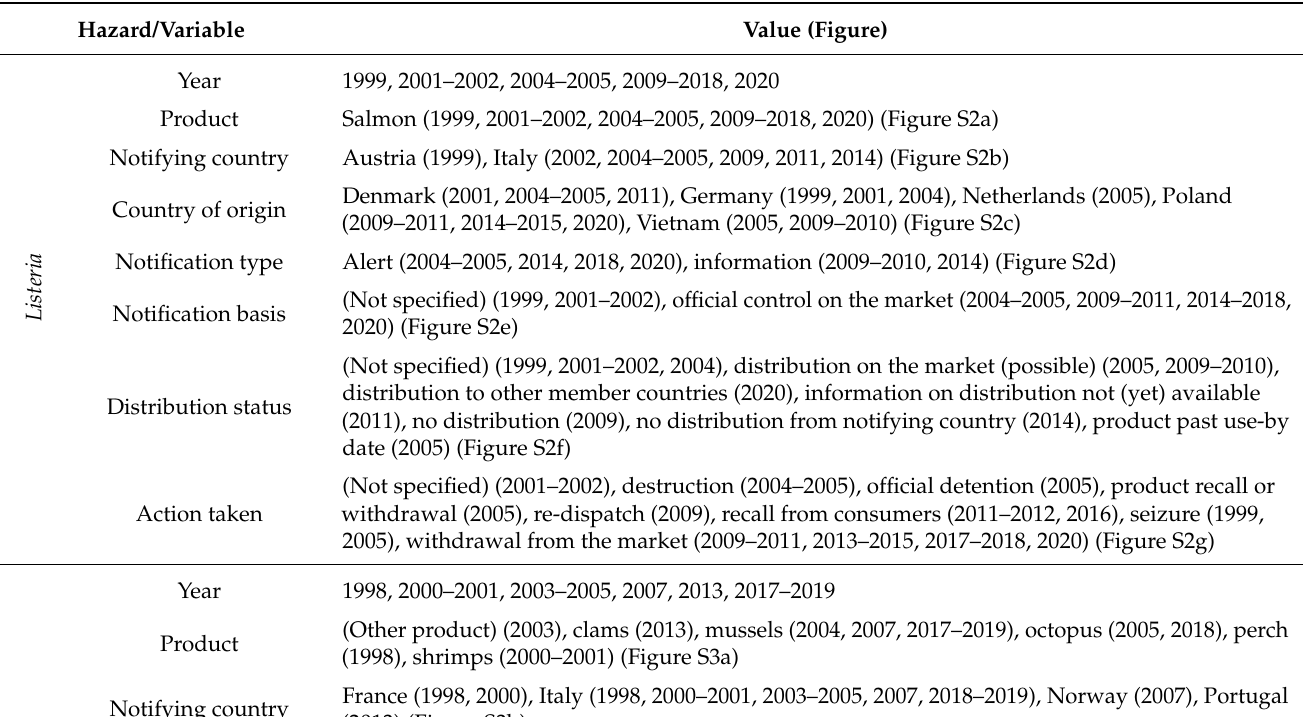
Table 5. Results of two-way joining cluster analysis related to notifications on micro-organisms in seafood in the RASFF in